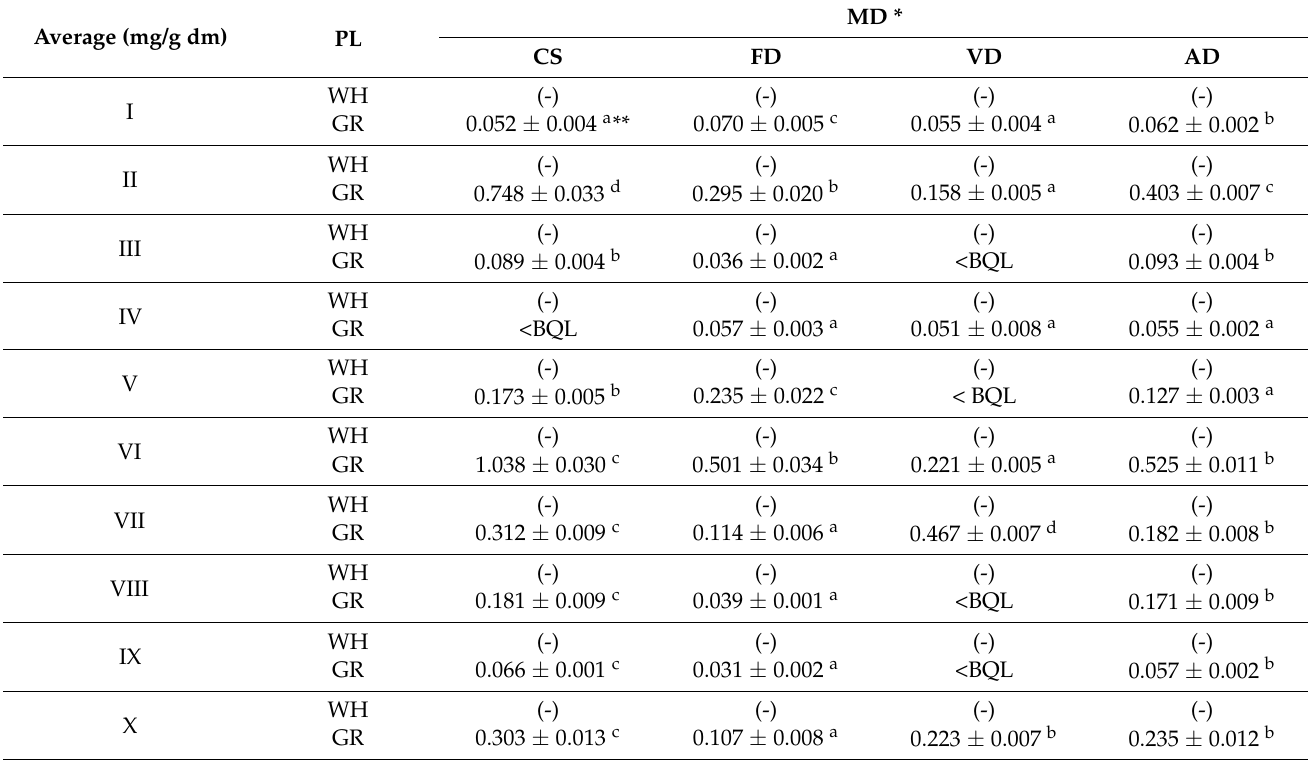
Table 8. Flavonoid contents I–X (kaempferol derivatives) in white and green shafts of leek. Average (mg/g